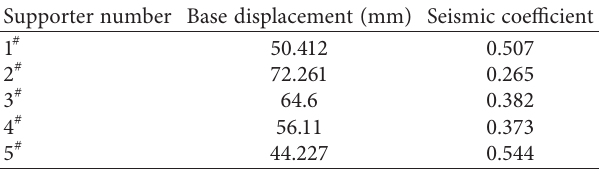
Table 10: LRB base displacement and seismic coefficient